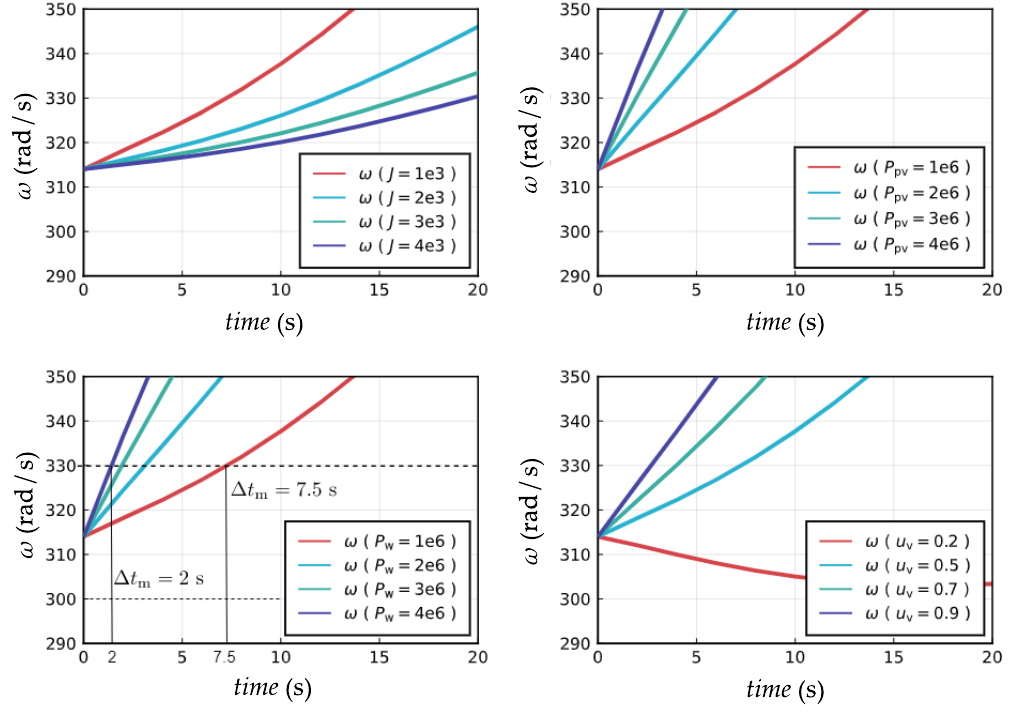
Figure 3. Deviations in ω due to J , P pv , P w and u v . The deviations in the grid frequency are proportional to the static power injected in the microgrid and the loading of hydro-turbine. ∆ t m is the maximum allowed discretization time for a controller to maintain the grid